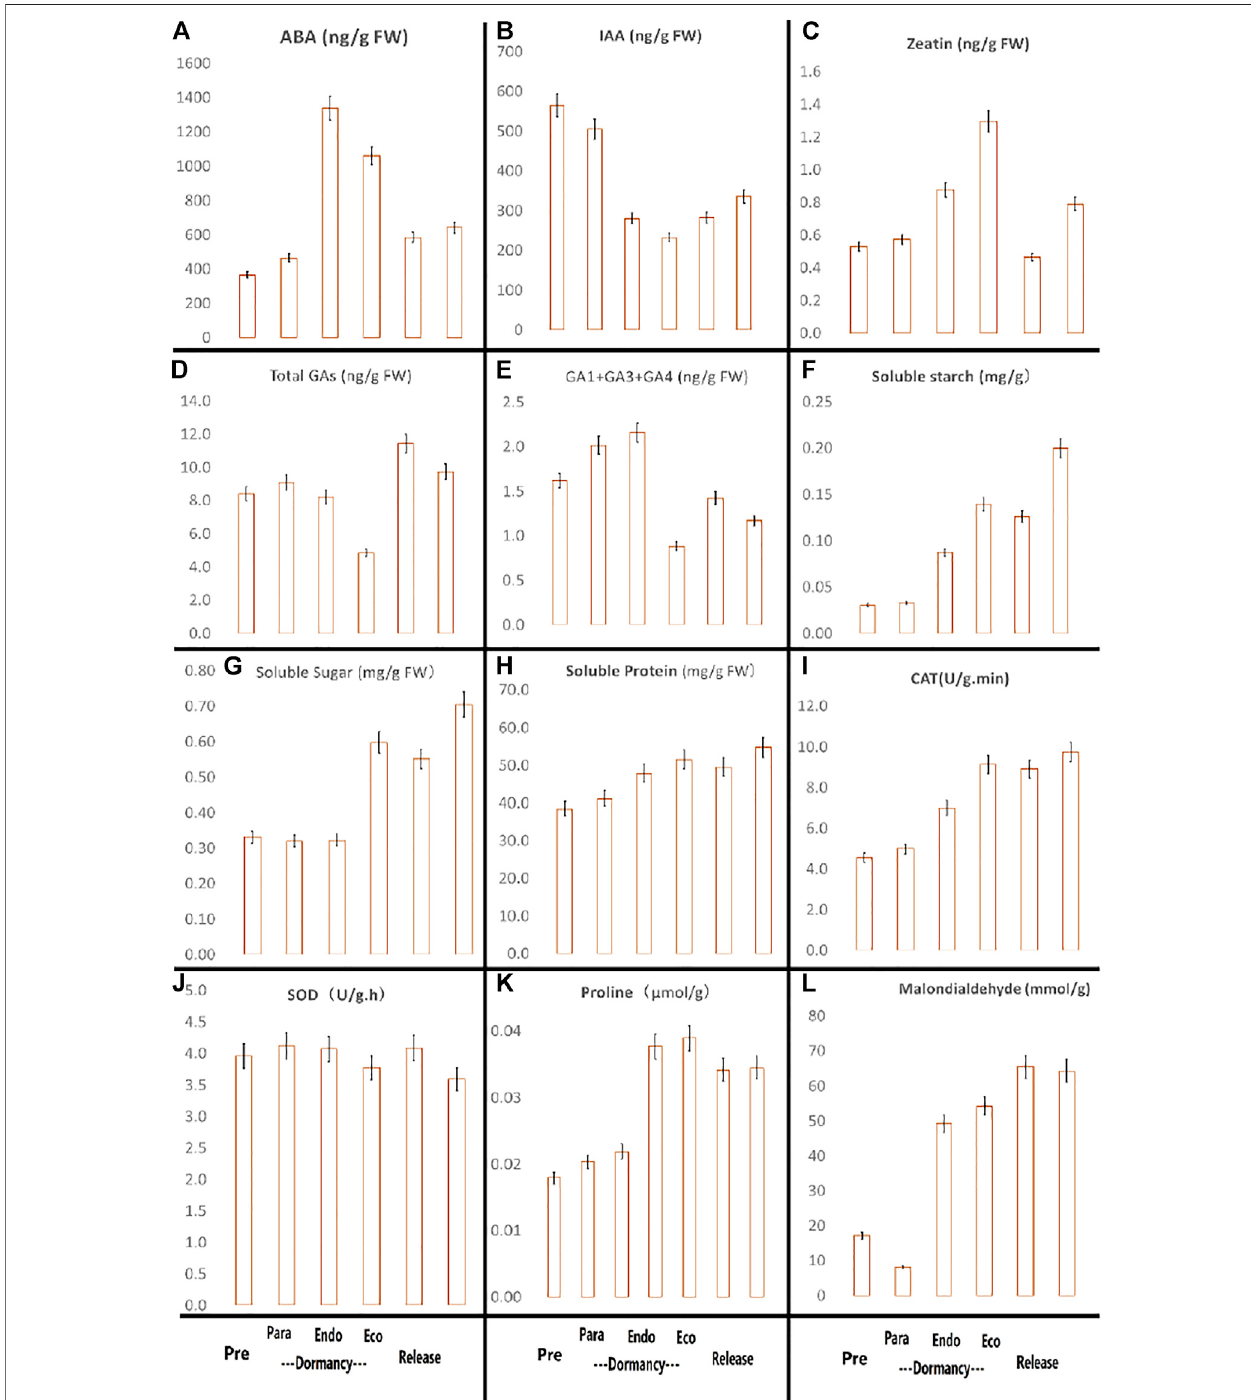
FIGURE 4 | Contents of endogenous phytohormones (A) ABA (ng/g FW: fresh weight), (B) IAA (ng/g), (C) zeatin (ng/g), (D) total GAs (ng/g), (E) bioactive GAs (GA1+GA3+GA4) (F) soluble starch (mg/g), (G) soluble sugar (mg/g), (H) soluble protein (mg/g), (I) CAT activity (U/g.min), (J) SOD activity (U/g.h), (K) proline contents (µmol/g), (L) MDA content (mmol/g) in fl ower buds during different dormancy phases.